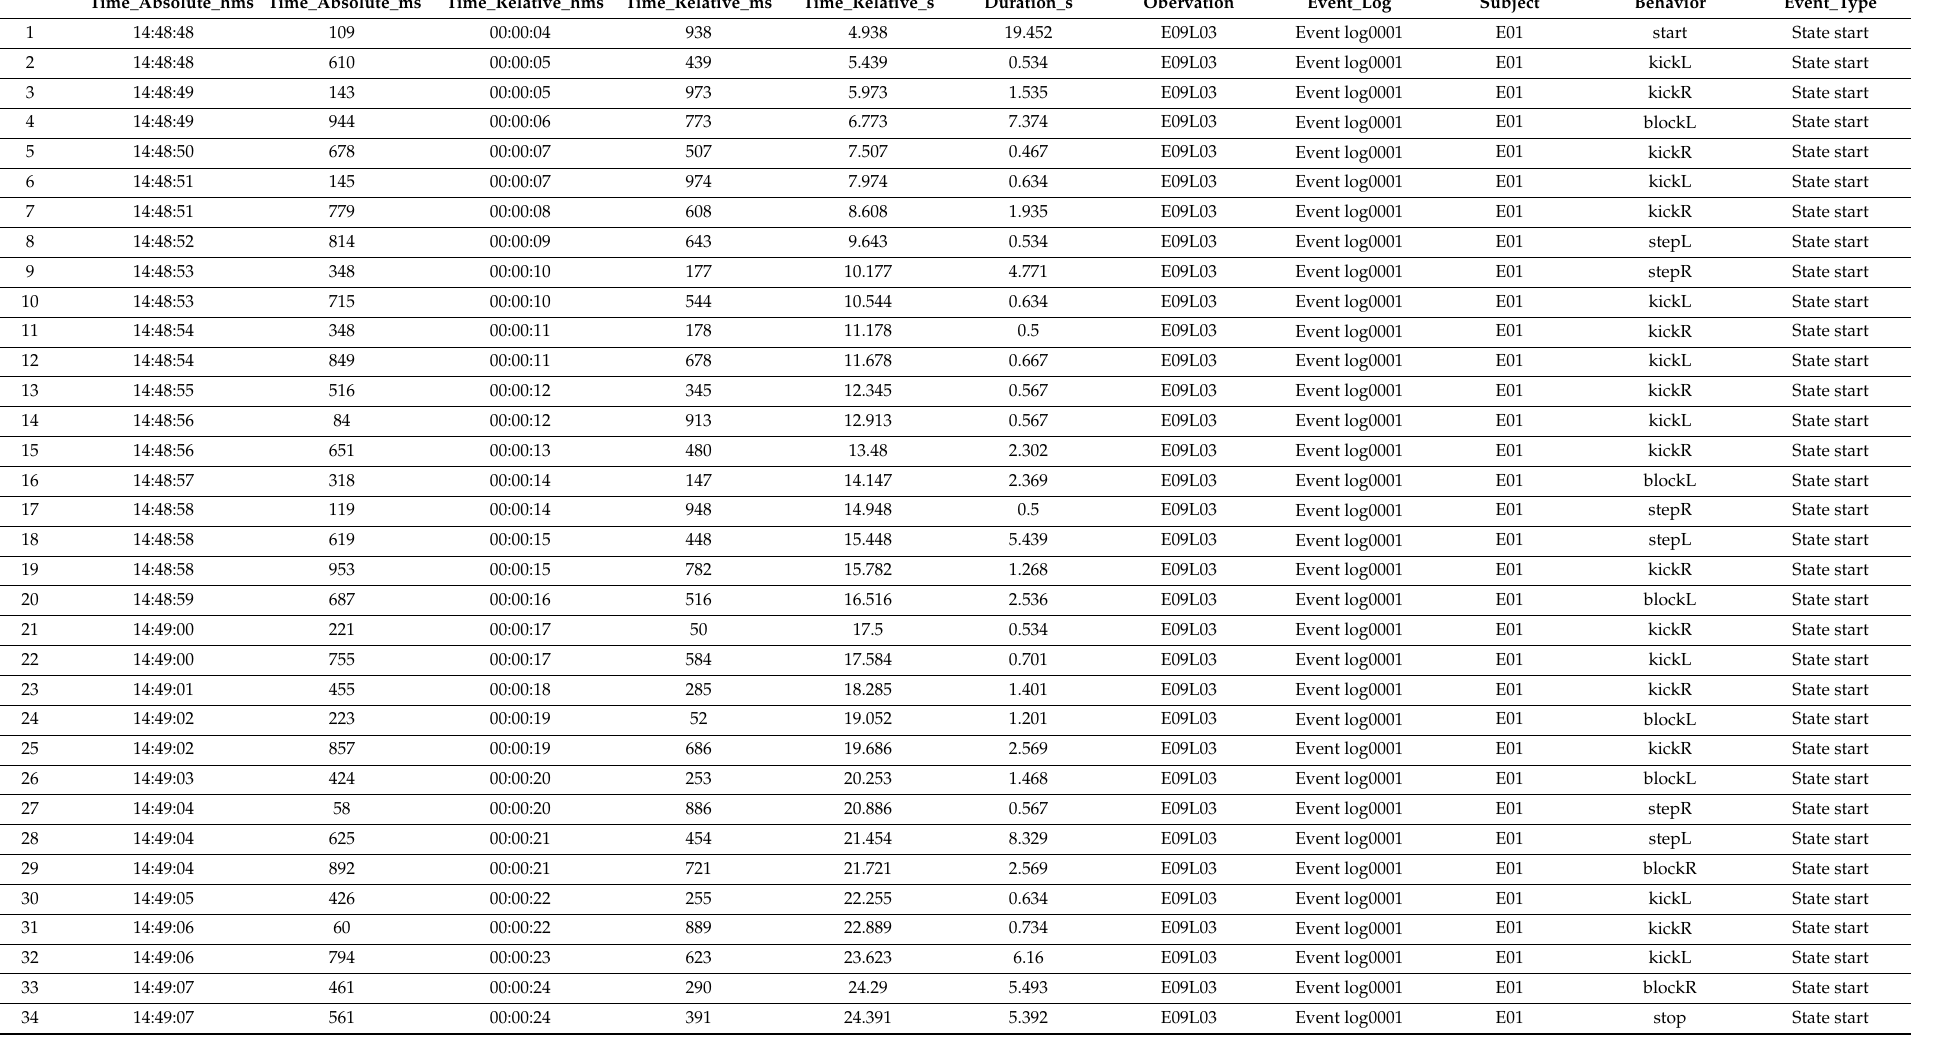
Table 3. A coding summary of a participant with ID during zigzag